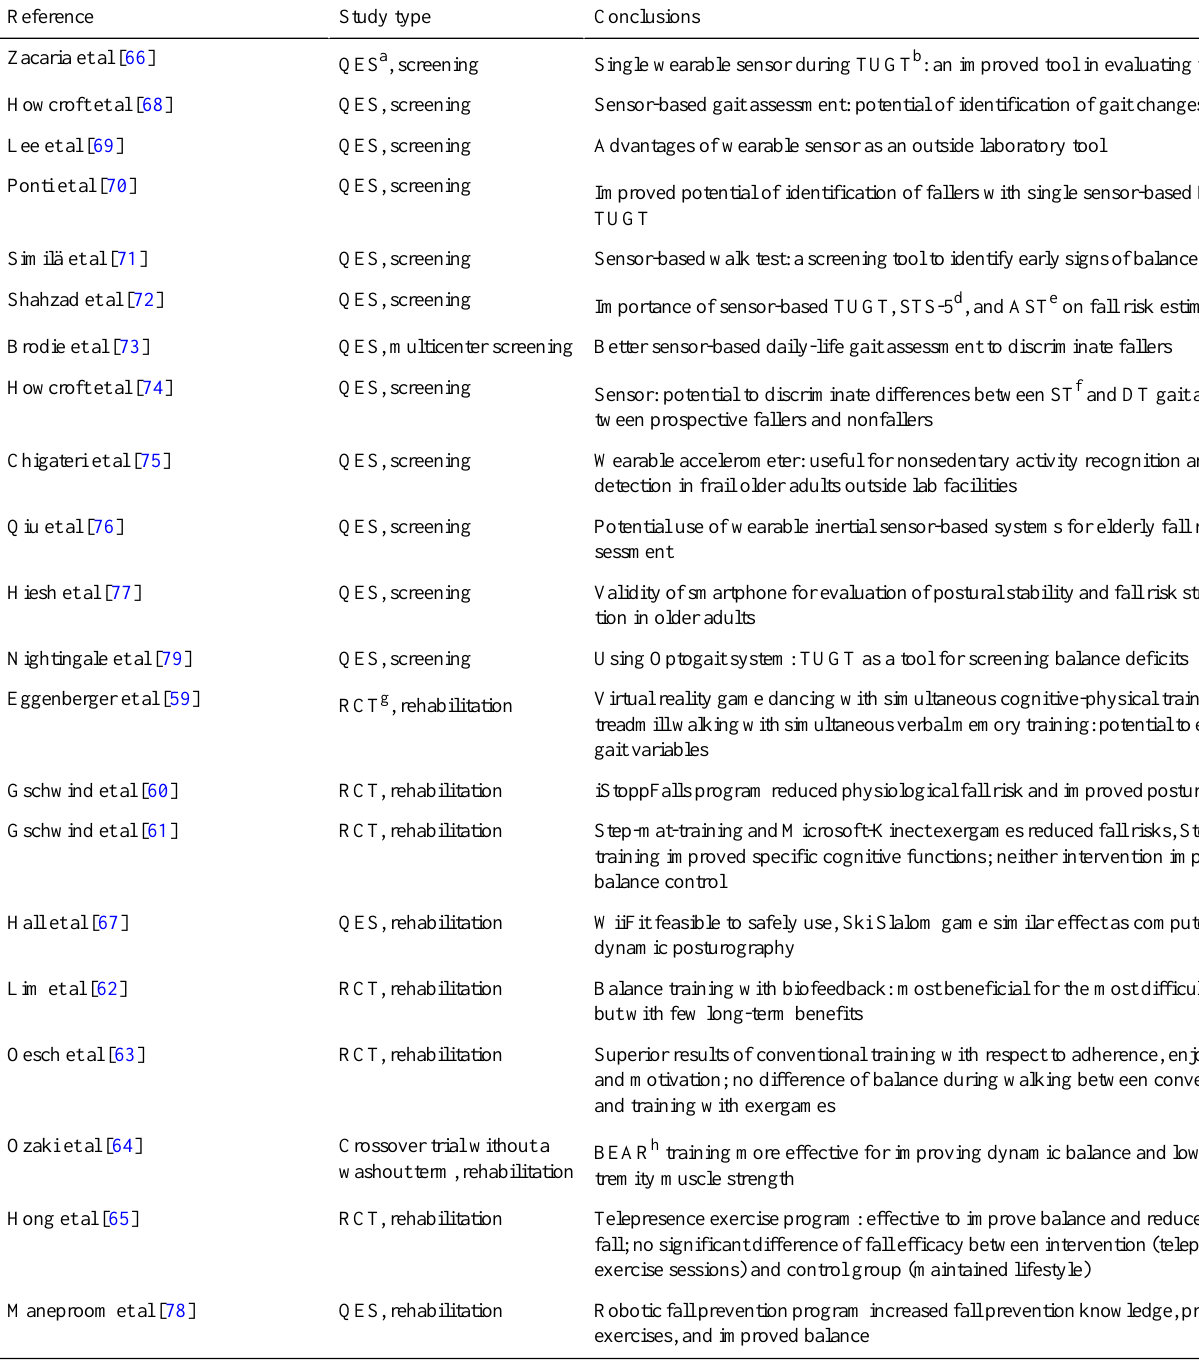
Table 7. Health benefits: conclusions from all studies.